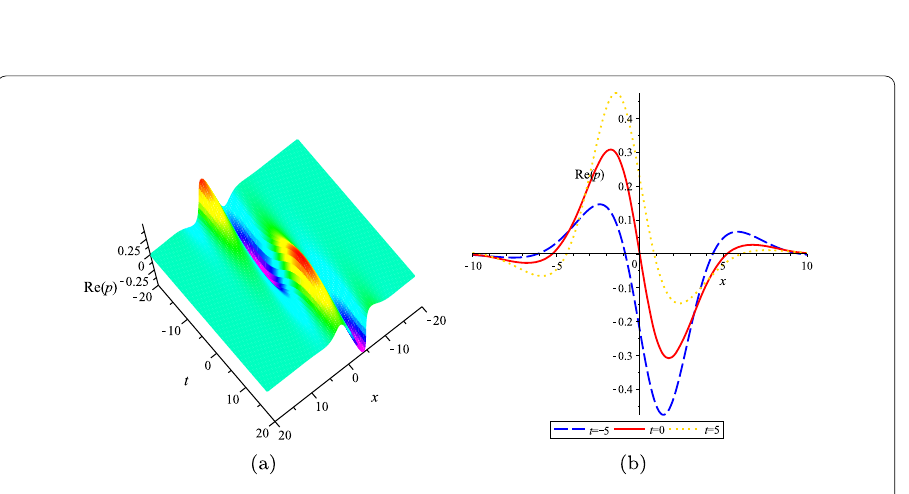
Figure 2 One-soliton solution (26) with ˜ a 1 = 0.3, ˜ b 1 = 0.25, α 1 = β 1 = 1, ξ 1 = 0. ( a ) Perspective view of the real part of p ; ( b ) The soliton along the x -axis with different time in Fig. 2(a)